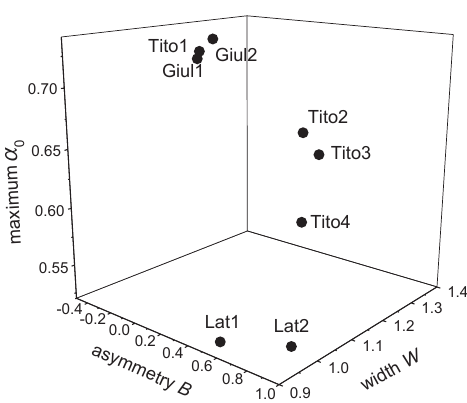
Fig. 6. 3D plot of the multifractal parameters: the signals Lat1 and Lat2, recorded in an aseismic area, are well discriminated from the signals (Tito and Giul) measured in seismic